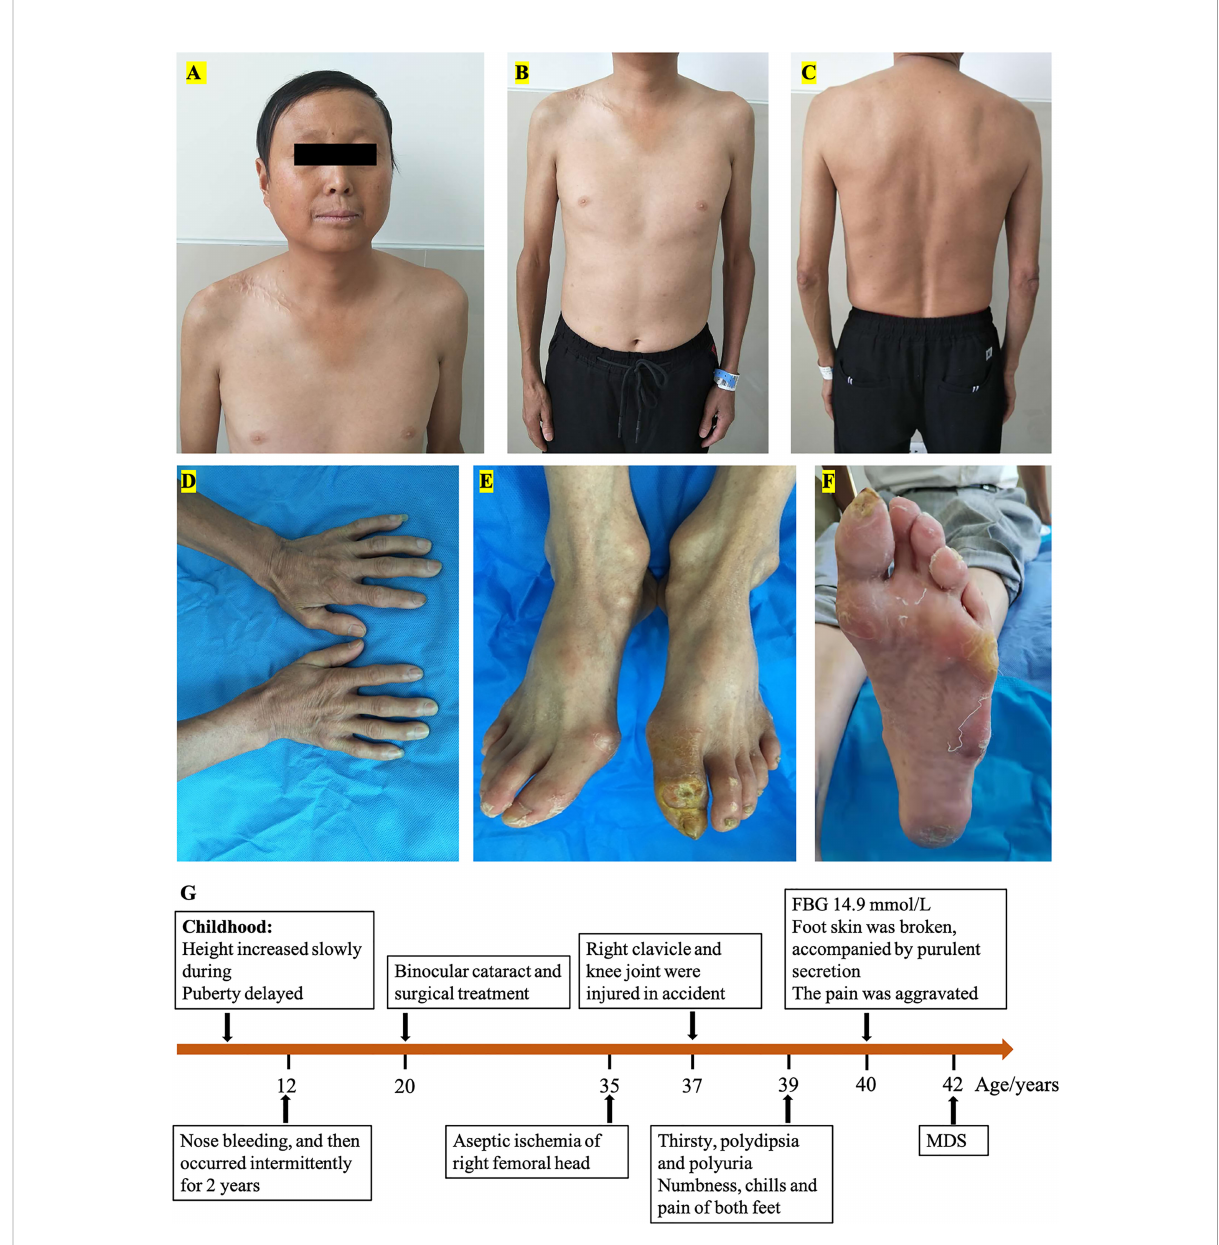
FIGURE 1 Patient ’ s characteristics: (A) face, (B) ventral trunk, (C) back of the trunk, (D) hands, (E) feet, (F) sole, and clinical history diagram (G)